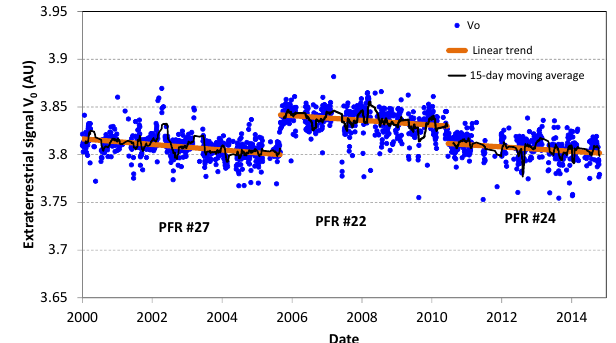
Figure 3. Mean number of suitable Langley calibrations per month at Mauna Loa and Izaña based on GAW-PFR and AERONET data (see text). Bars indicate ± 1 standard deviation for each month due to year-to-year variability. Morning (“am”) and afternoon (“pm”) Langley plot calibrations are given separately.